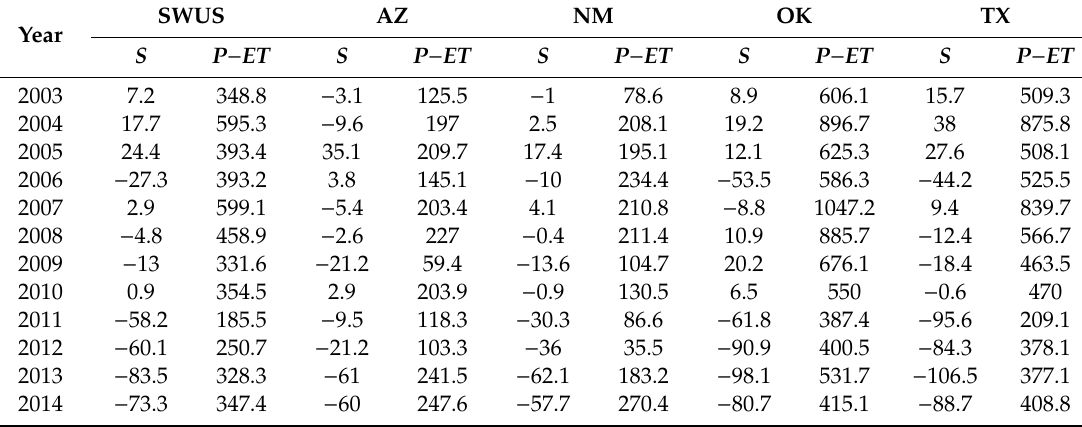
Table 1. Annual water storage, precipitation minus evapotranspiration in SWUS from 2003 to 2014 ( S : water storage estimated from GRACE; P − ET : precipitation minus evapotranspiration